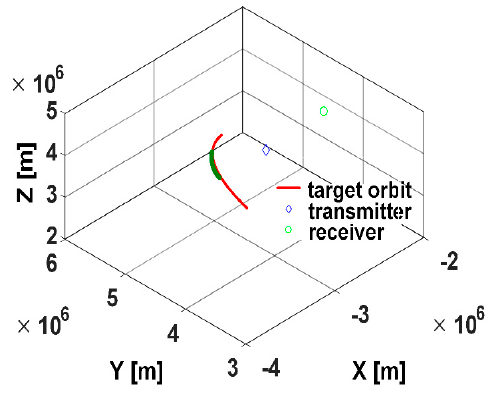
Figure 4. Simulation scenario.